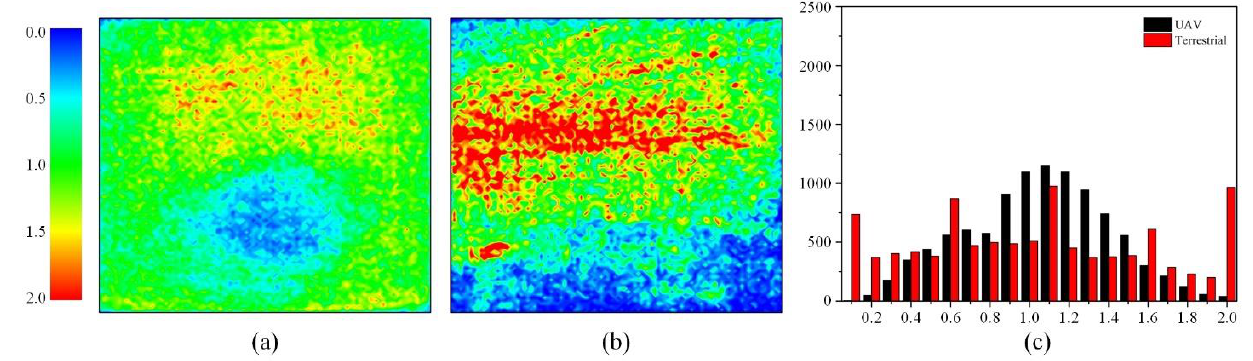
Figure 12. Tie point distributions for the SZU-YPS dataset: ( a ) aerial (UAV) and ( b ) terrestrial image spaces; ( c ) histograms.